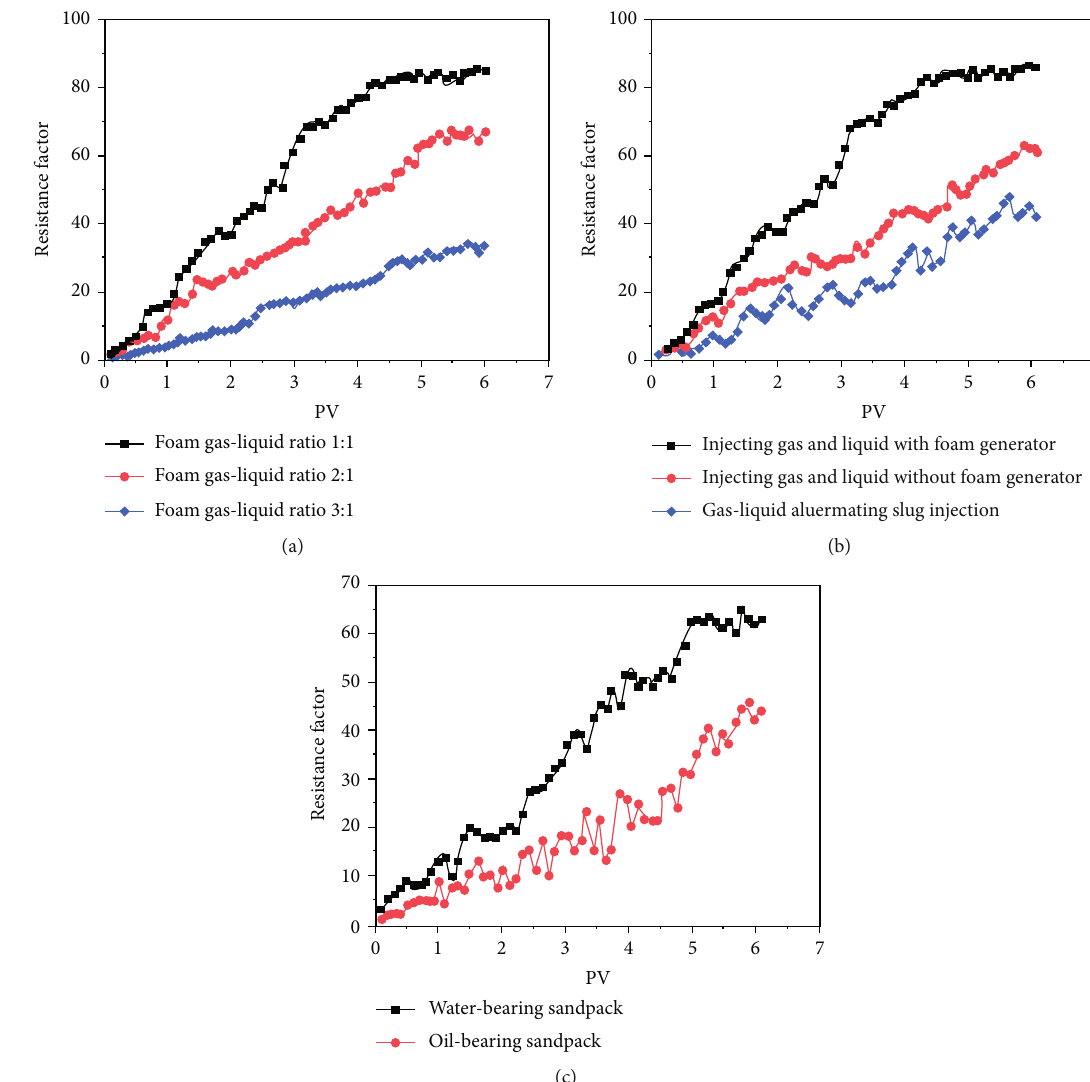
Figure 6: The result of parameters a ff ects